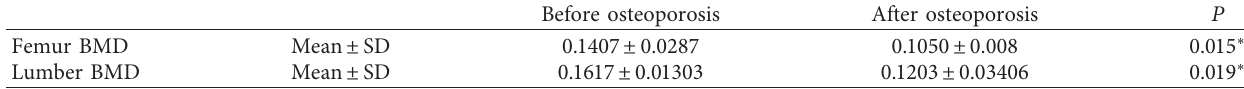
Table 1: Comparison of femur and lumber spine BMD before and after osteoporosis using unpaired Student’s t -tests. Before osteoporosis After osteoporosis P